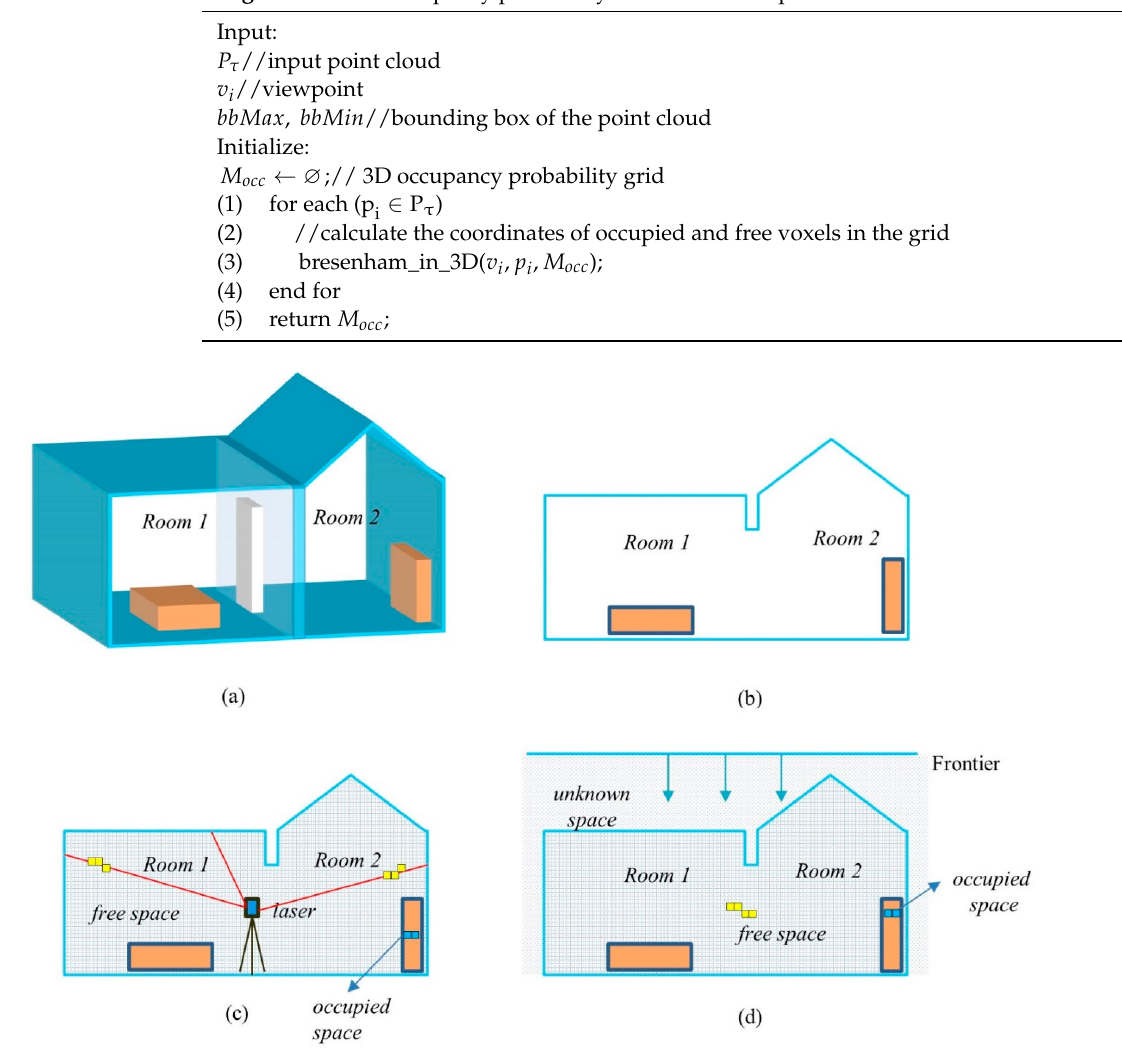
Algorithm 1. 3D occupancy probability calculation for a point cloud.